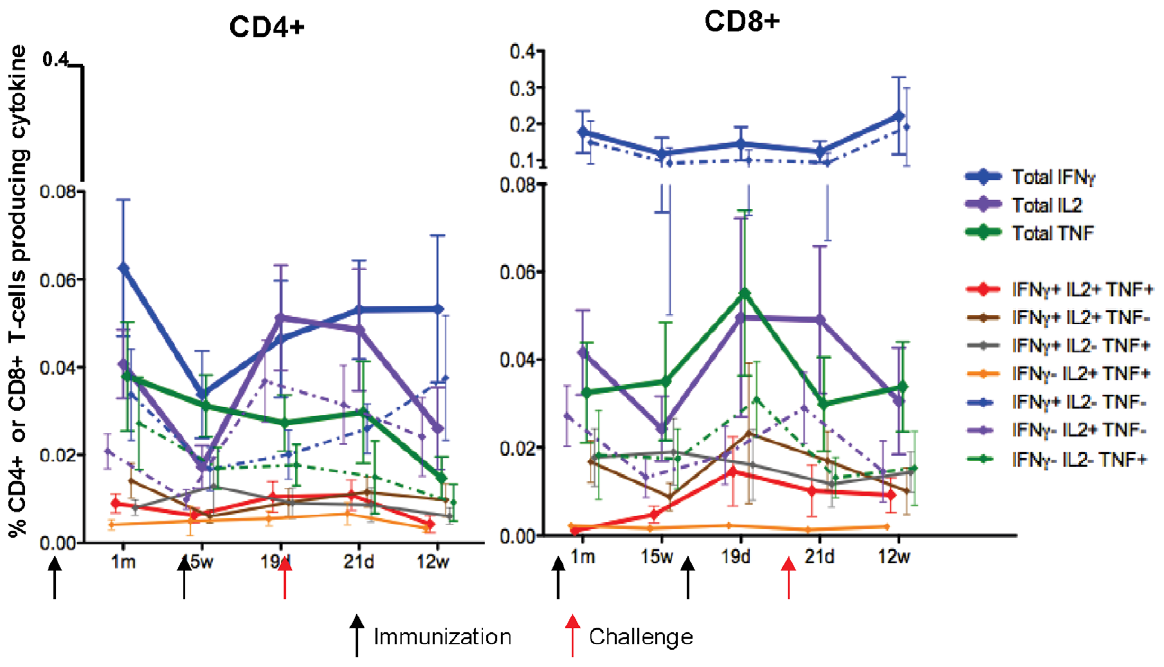
Figure 6. ICS CD4 + and CD8 + T cell multifunctional CSP responses. Arithmetic group mean percents with standard error of the mean for all cytokine phenotypes (total IFN- c , total IL-2 or total TNF- a in bold solid lines, only IFN- c , only IL2 or only TNF- a in dotted lines, and other subsets as non-bold solid lines). Responses prior to immunization are subtracted from all data in order to show only vaccine-induced responses.